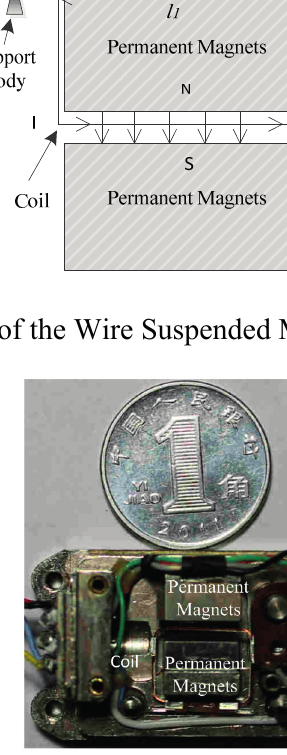
Figure 2. A Wire Suspended Micro-Pendulum